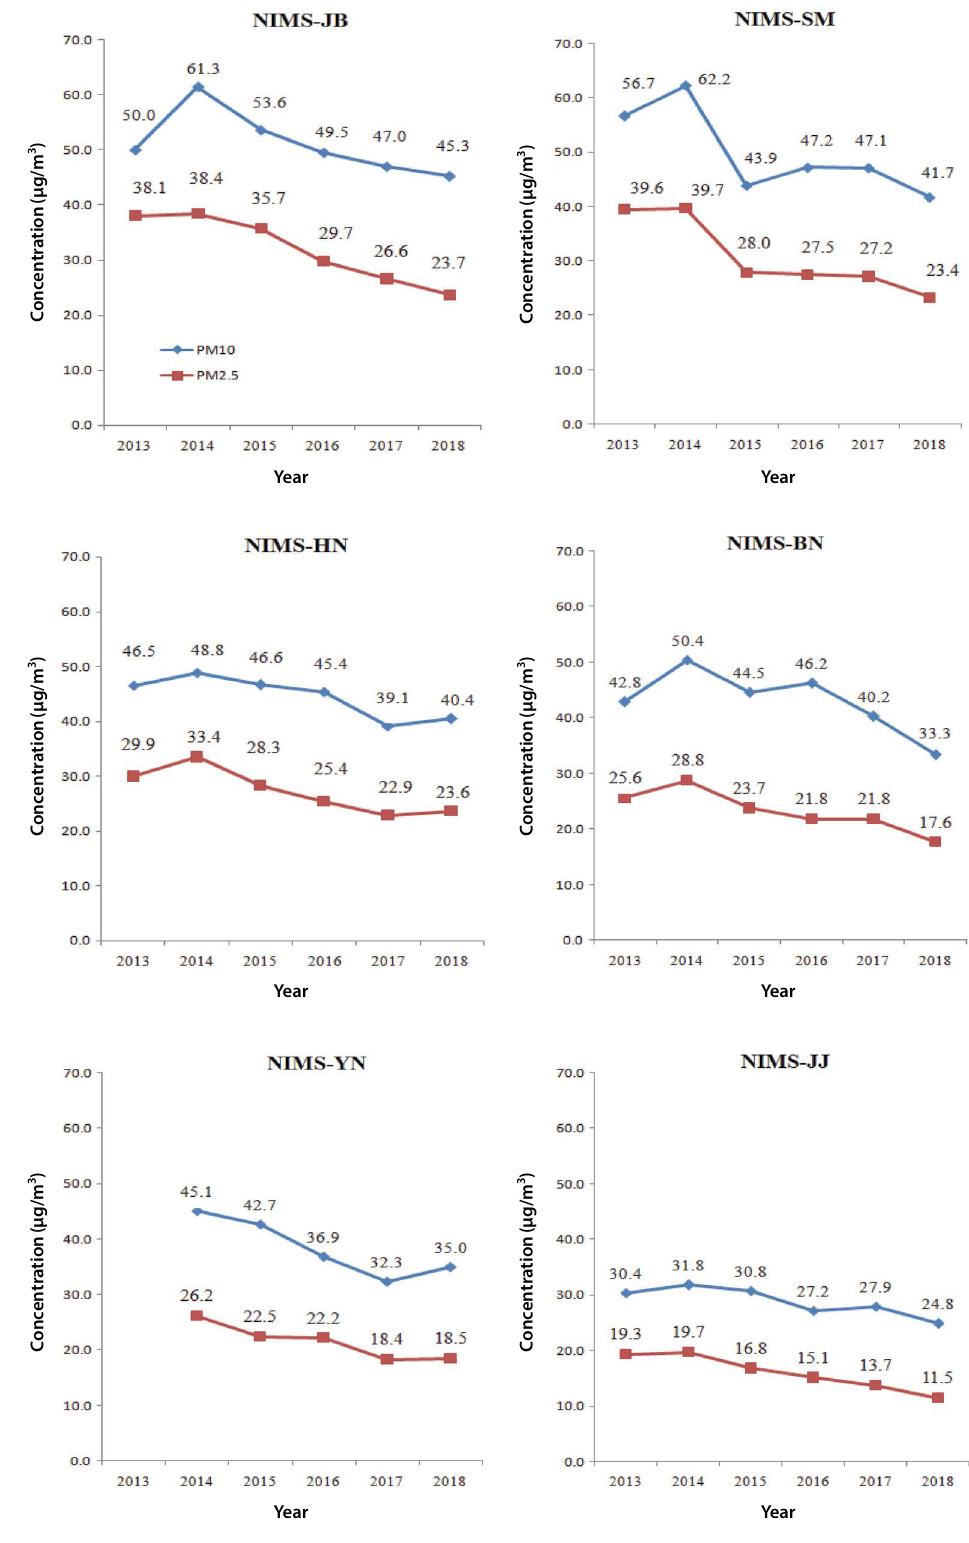
Fig. 3. Trends of annual average PM 10 & PM 2.5 concentrations at the 6 NIMSs during